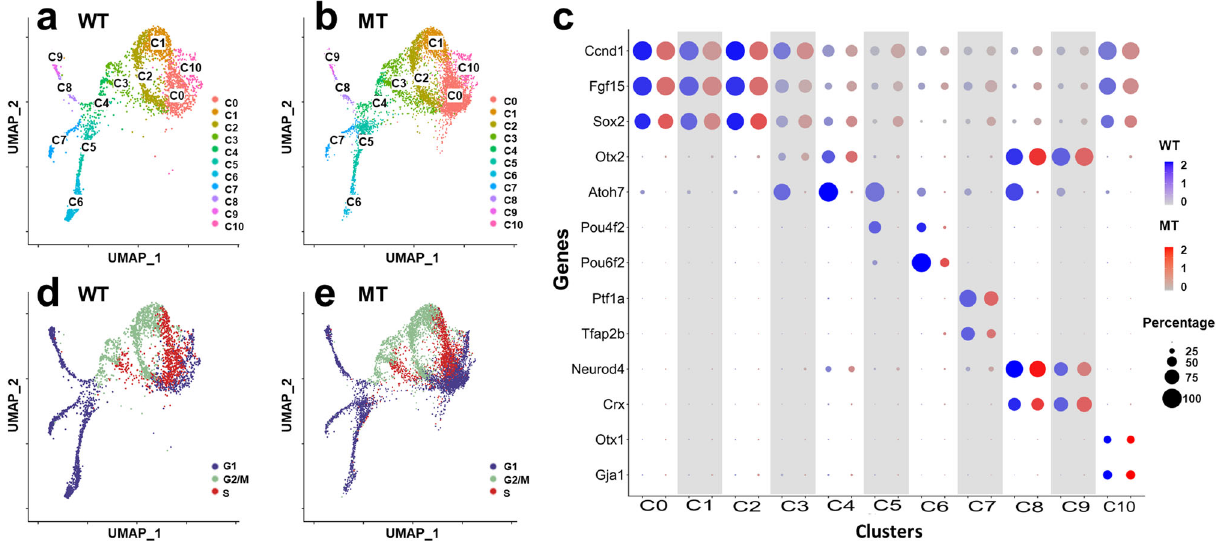
Fig. 3 scRNA-seq analysis of E13.5 wild-type (WT) and Atoh7 -null (MT) retinas. a , b As indicated, uniform manifold approximation and projection (UMAP) clustering leads to the same 11 overlapping clusters (C0 – C10) with both WT ( a ) and MT ( b ) retinal cells. c Expression of known markers genes as represented by a dot plot enables identity assignment of individual WT and MT clusters (see text for details). As indicated, the sizes of the dots indicate the percentage of cells expressing the gene in individual clusters and the color intensities denote average expression levels. Color scales represent natural- log transformed normalized gene expression levels as described in “ Methods ” . d , e Cell cycle analysis determines the cell cycle status (G1, S, and G2/M) of individual cells in the clusters. Note that largely the same cell cycle distribution is observed in the WT ( d ) and MT ( e ) retinas, and that the cell cycle statuses correlate with UMAP